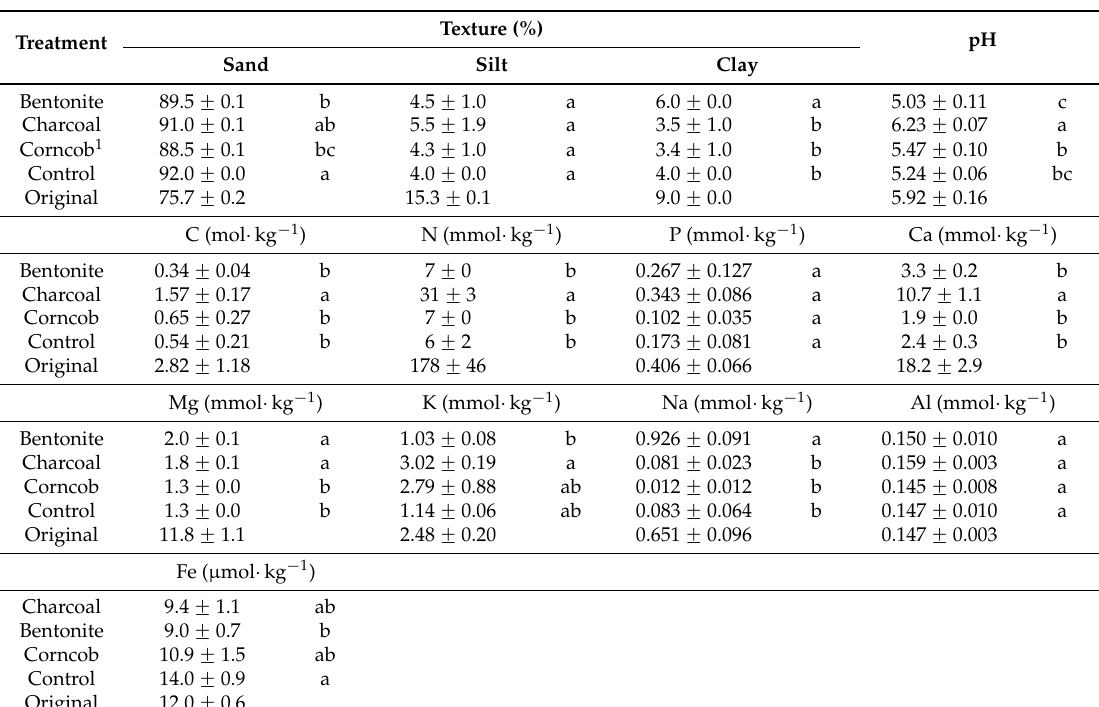
Table 1. Texture and chemical properties on soils of four treatments and original soil with the seedlings (Mean ˘ SE, n = 4). Different letters indicate significant differences among the four treatments calculated by Tukey’s test ( p <